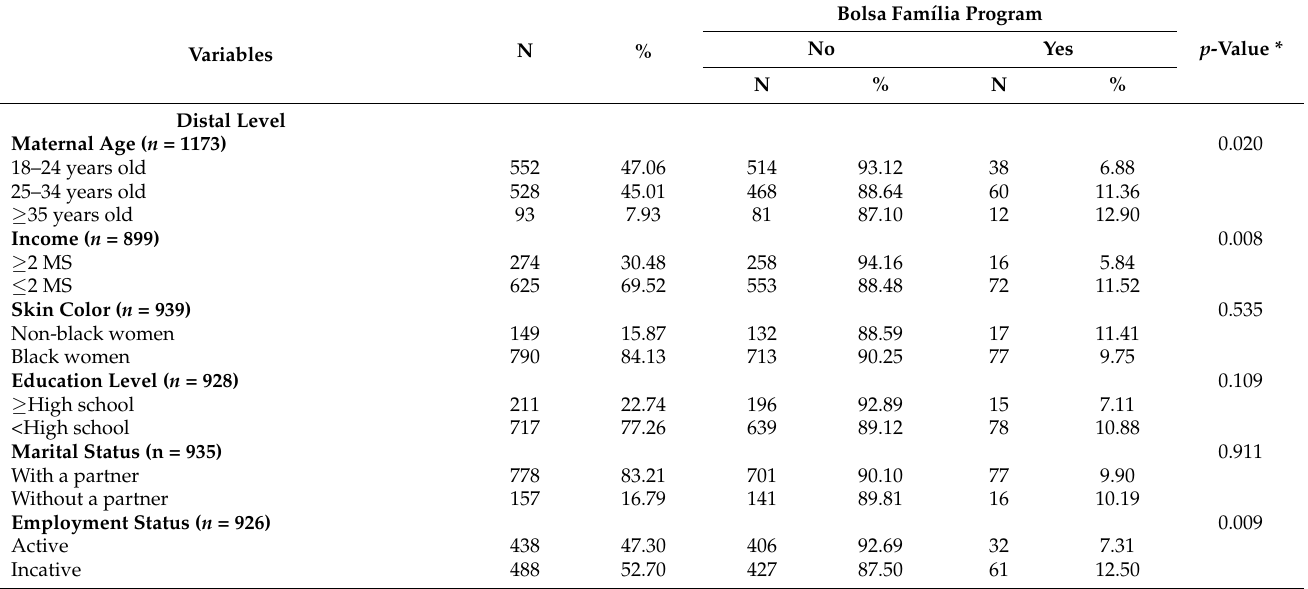
Table 1. Distribution of sociodemographic, economic, prenatal, lifestyle and nutritional